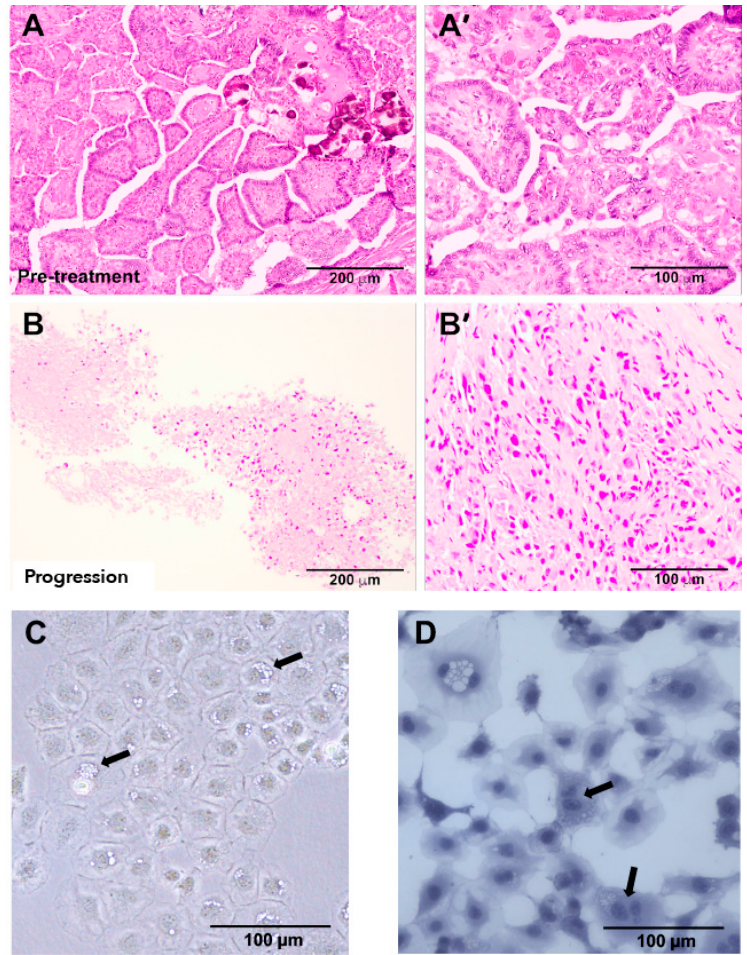
Figure 1. Samples histology of a PTC patient before and after dabrafenib treatment, and morphology of a derived cell line. ( A ) H&E preparation of a pretreatment sample showing papillary thyroid cancer histology. ( A’ ) Enlargement of A showing cells organized in papillae. Cells present with enlarged nuclei with irregular contours, intranuclear inclusions, and pale chromatin. ( B ) Overall histology of a mediastinal metastasis sample at progression (FNA, H&E preparation). ( B’ ) Enlargement of B showing cells distributed without an organized pattern. Cells have a spindle or round cell morphology resembling poorly differentiated (PDTC) or anaplastic (ATC) thyroid cancer. ( C ) Phase contrast micrograph showing the cobblestone arrangement of PDX.008.CL cells in culture. Cells are mostly round or cuboidal with round nuclei containing prominent nucleoli. The cytoplasm also contains prominent vacuoles (arrows). ( D ) Hematoxylin staining of PDX.008.CL cells in culture showing multinucleated cells (arrows).